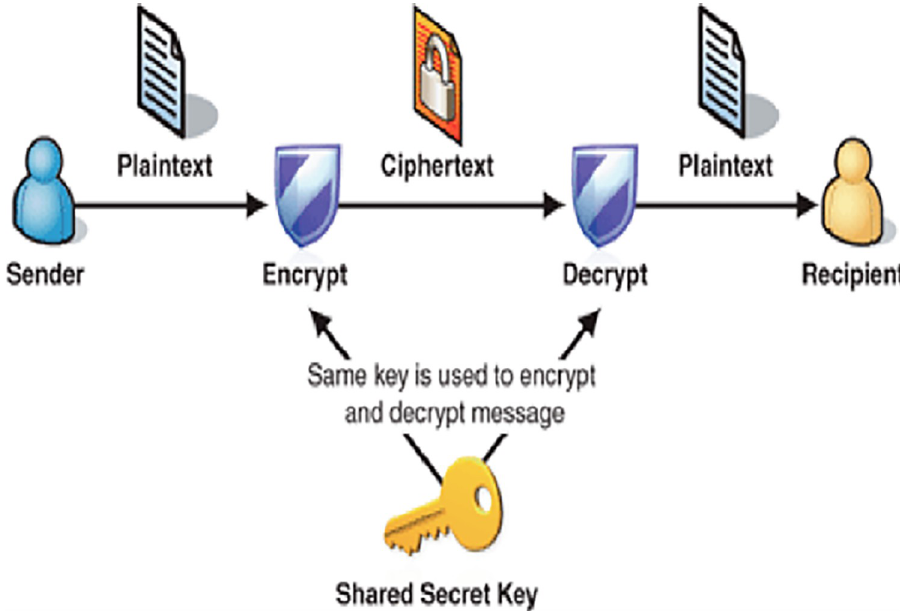
Fig 2. A confidential scheme using a symmetric key